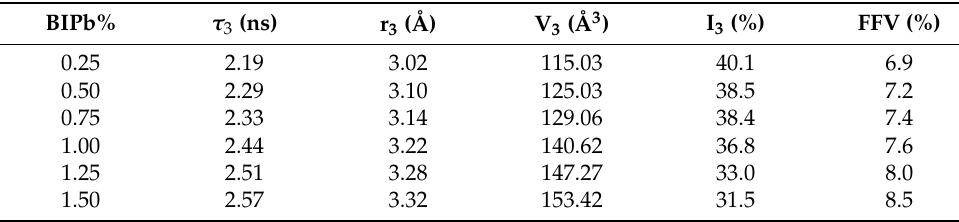
Figure 9. Positron lifetime spectra measured for cured samples. Table 6. Summary of the PALS analysis results of different